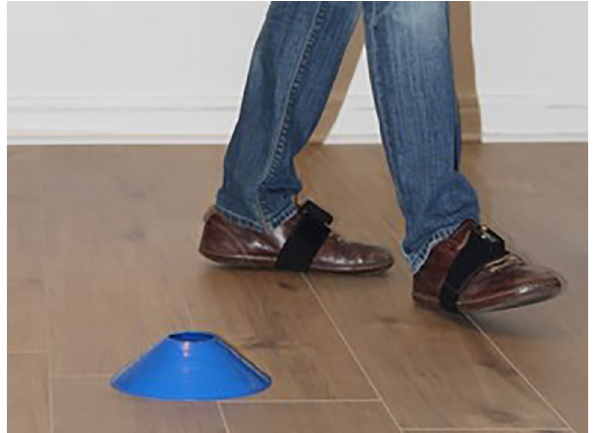
Figure 1. Picture showing the placement of the two foot-worn inertial sensors.